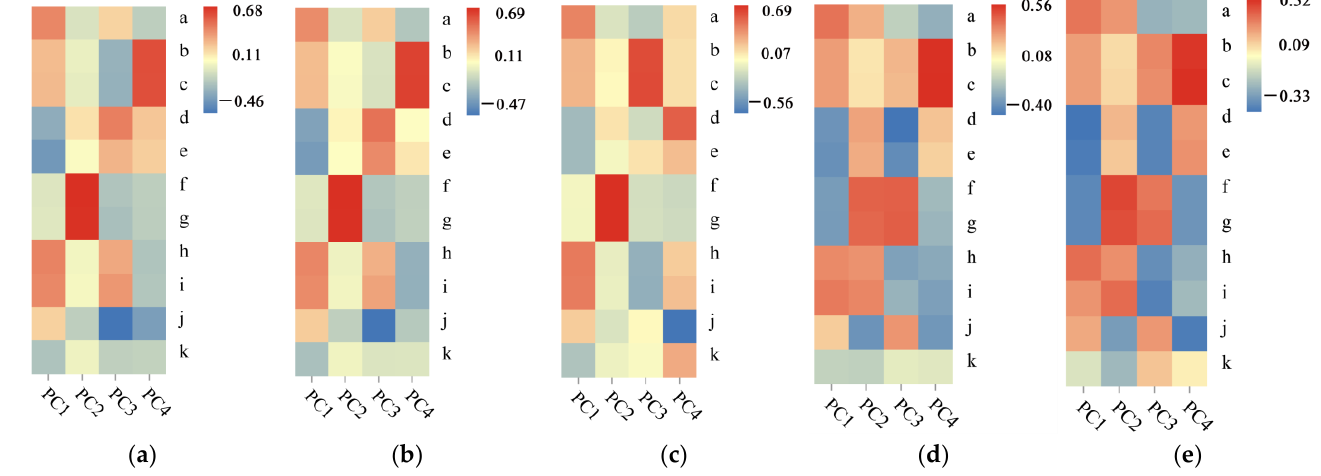
Figure 3. Index weights of ecological vulnerability assessment in red soil erosion area of Changting from 2000 to 2020. ( a – e ) represent 2000, 2005, 2010, 2015 and 2020, respectively. a stands for eleva- tion, b stands for slope, c stands for relief degree of land surface, d stands for land use type, e stands for NDVI, f stands for population density, g stands for GDP density, h stands for annual average temperature, i stands for annual average precipitation, j stands for landscape diversity, and k rep- resents soil erosion intensity.